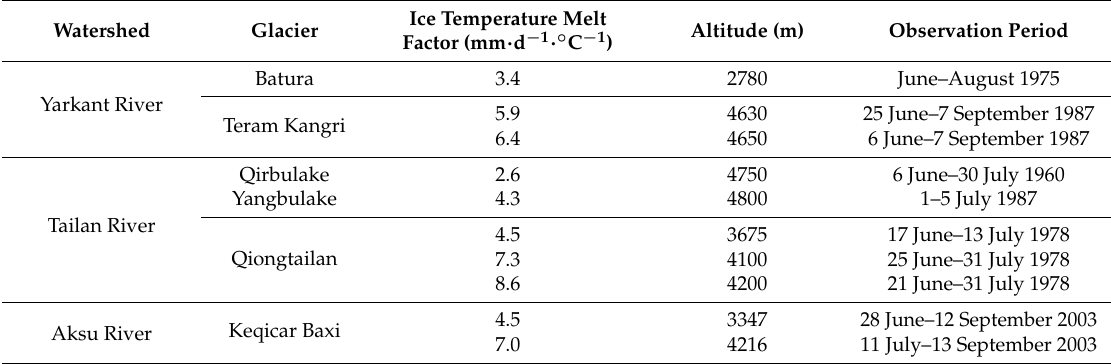
Table 1. Ice temperature melt factors of different observed glaciers in the Tarim River Basin.